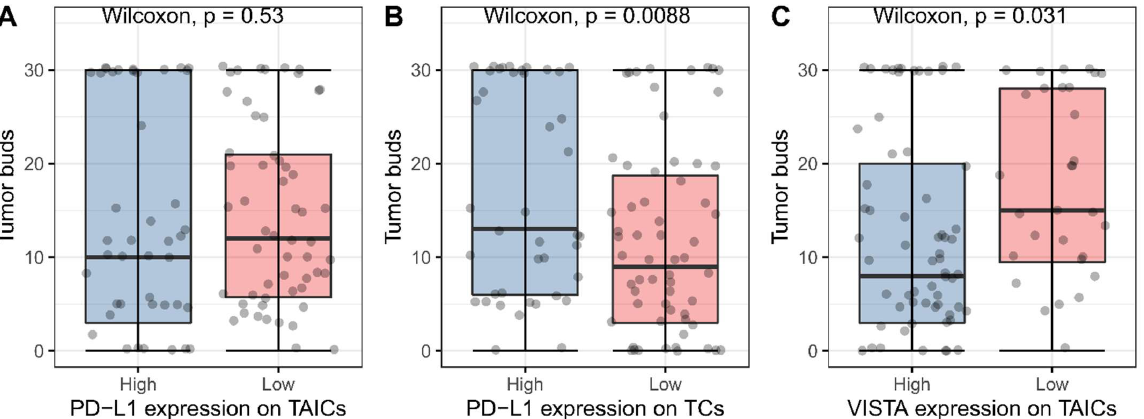
Figure 3. Association between PD-L1 and VISTA expression and the number of tumor buds ( A – C ). Blue and red boxes represent high and low expression of immune checkpoint receptors, respectively. Grey dots represent individual measures.